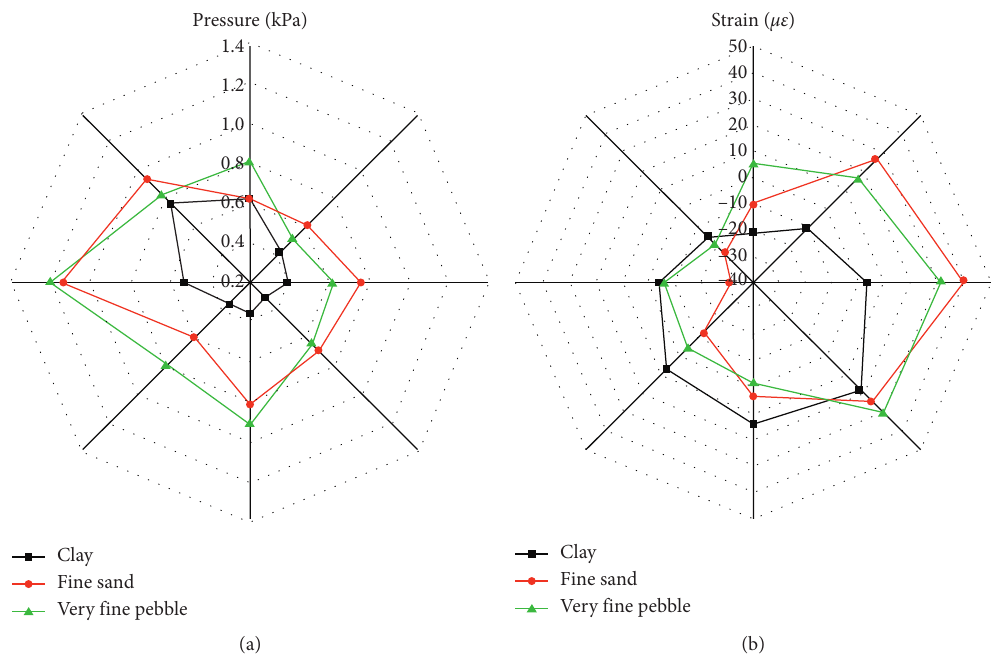
Figure 11: Pressure and strain on the surface of the pipeline when half of the pipeline is buried and half exposed: (a) pressure on the surface of the pipeline when the embedment ratio is − 0.5 and (b) strain on the surface of the pipeline when the embedment ratio is −